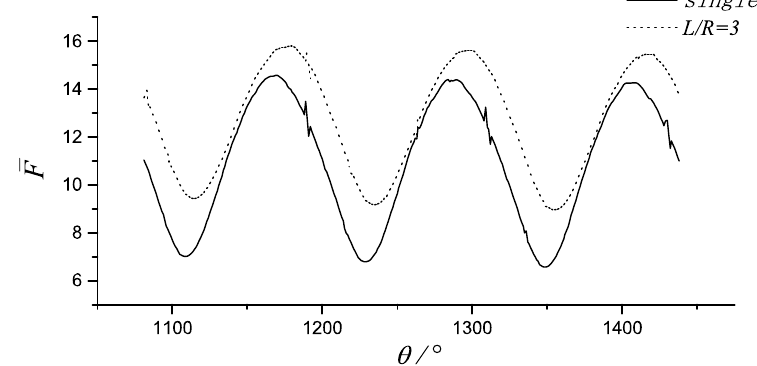
Figure 13. The comparison of the turbine resultant force coefficient in the parallel and single situation where Z = 3 and λ = 2.5.